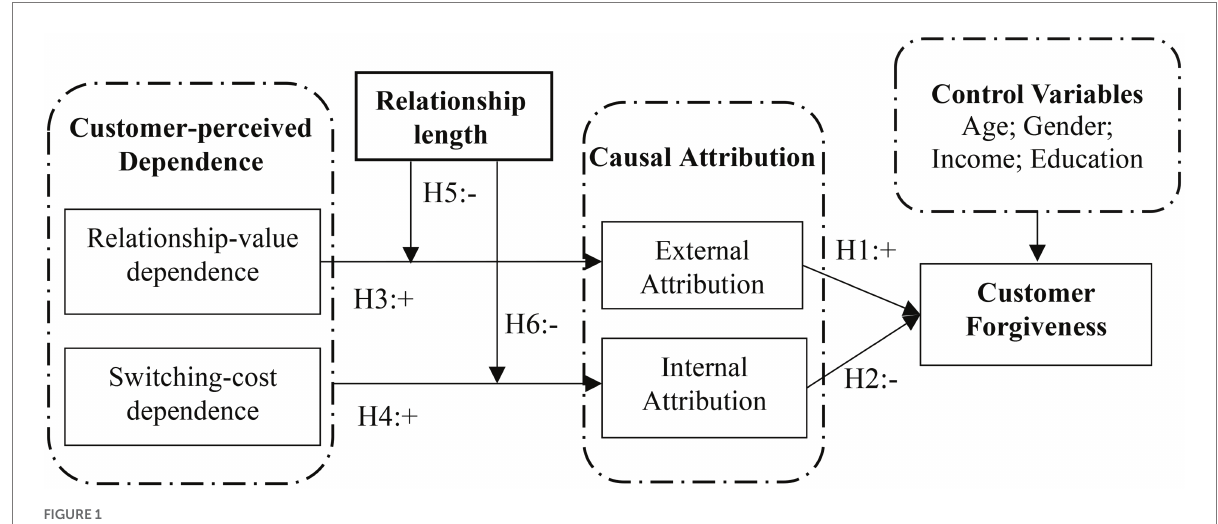
FIGURE 1 Conceptual model of our